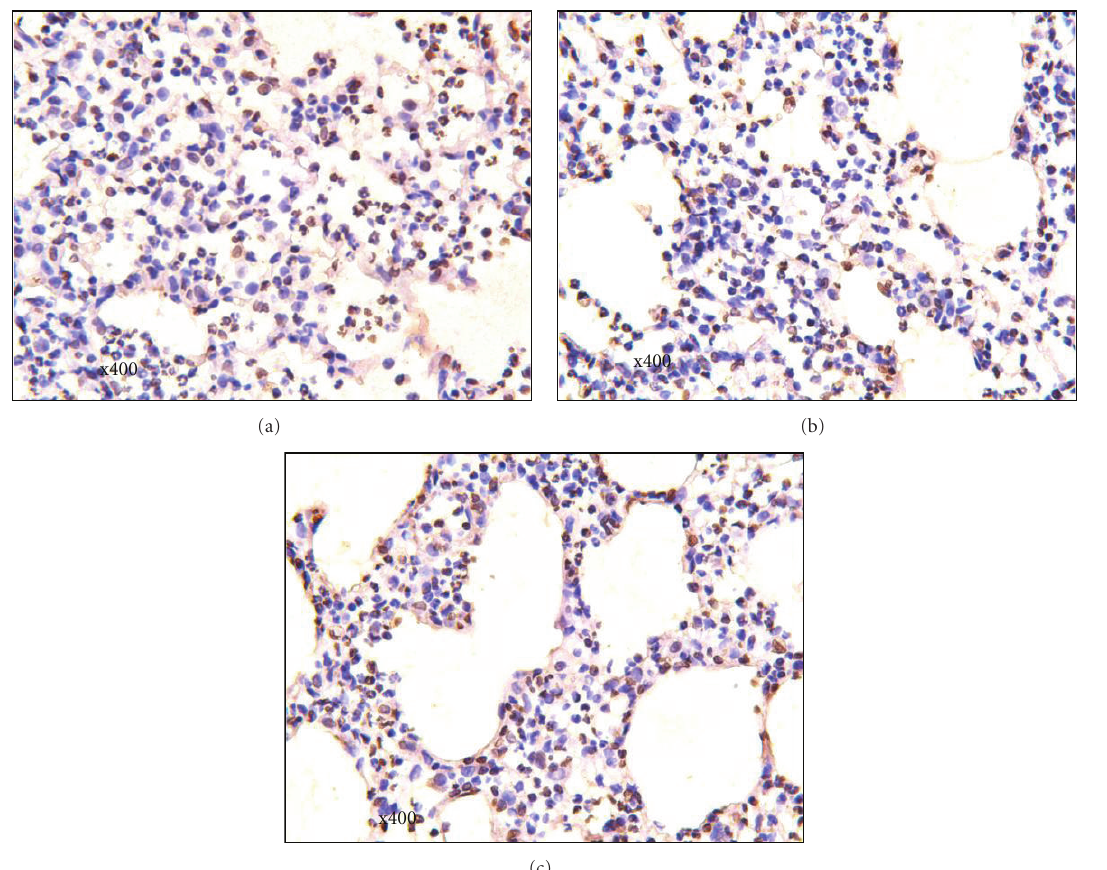
Figure 7: Apoptotic changes in alveolar epithelial and endothelial cells. Frozen tissues from the left inferior lung were routinely sectioned (20 μ M), fixed, digested, and incubated in 0.3% H 2 O 2 and methanol and 0.1% Triton X-100. then reacted with TUNEL reaction mixtures, peroxidase, and DAB substrate solution. The apoptotic cells showed brown nuclei following DAB stain, while the nonapoptotic cells presented blue nuclei following costain with H&E. The average apoptotic cells were calculated in 10 random high-power fields per section under photomicroscope (10 × 40). (a) LPS group; (b) sham-LCAP group; (c) lCAP group. The arrows indicate apoptotic staining in